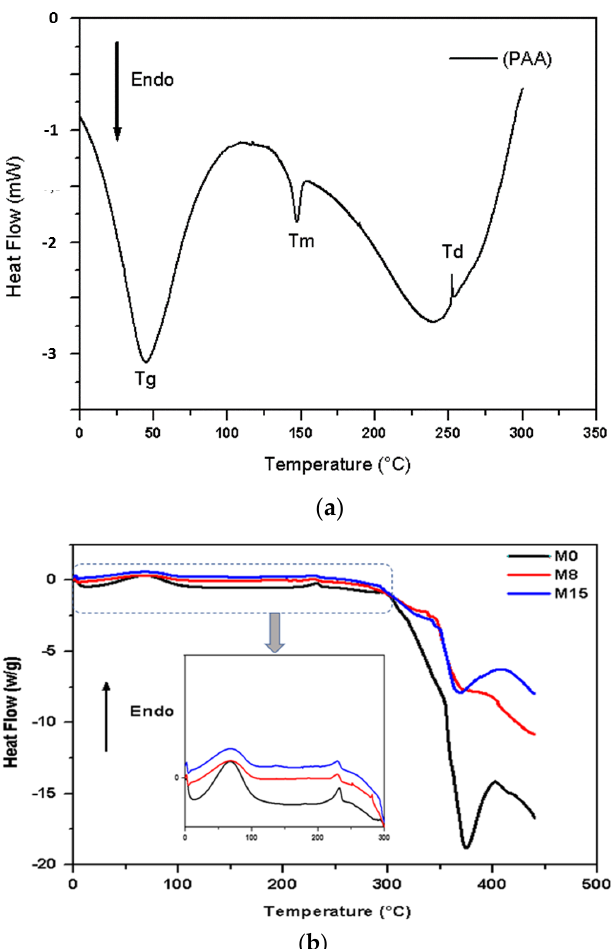
Figure 2. DSC thermograms of the ( a ) pure PAA polymer and ( b ) of the membranes prepared in this work.